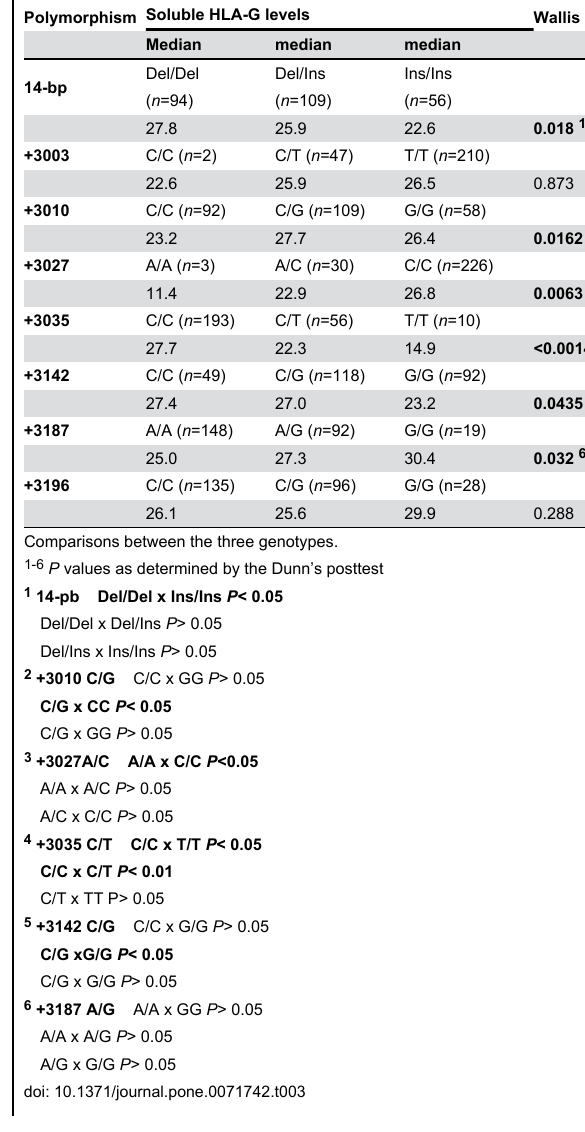
Polymorphism Soluble HLA-G levels